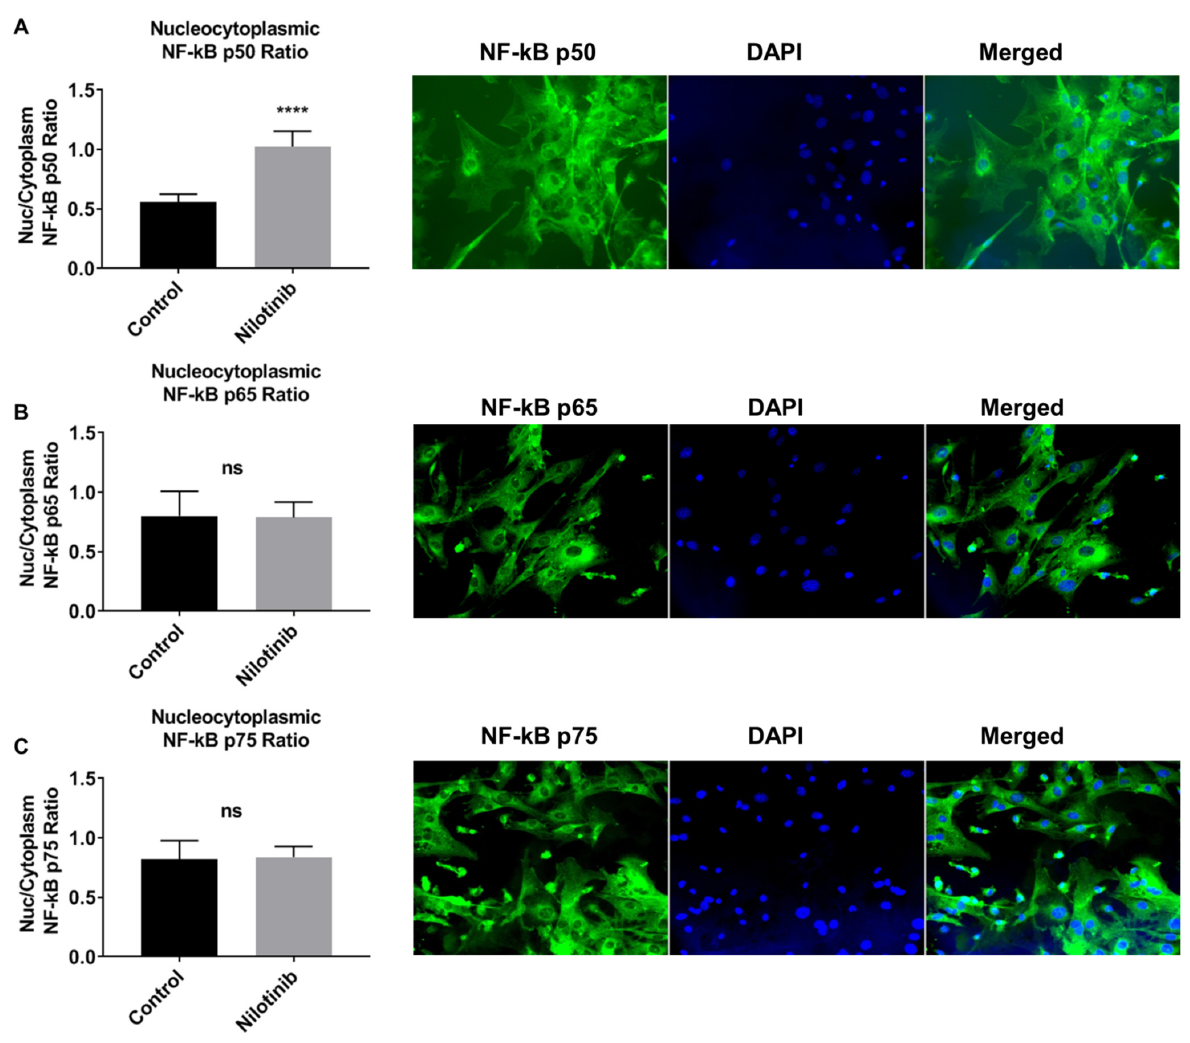
Figure 2. Nilotinib translocated the NF- κ B p50 subunit into the nucleus of 3xTg-AD astroglia. Quantitative immunofluo- rescent nuclear/cytoplasmic ratios of NF- κ B subunits (p50 ( A ), p65 ( B ), and p75 ( C )) in 3xTg-AD astroglia. DAPI (blue) marks the nucleus. Images were captured at 100× magnification. Volume density of NF- κ B subunits immunofluorescence was quantified using ImageJ software (**** p ≤ 0.0001); n = 5 per group analyzed by unpaired Student’s t -test. Reproduced from [104].